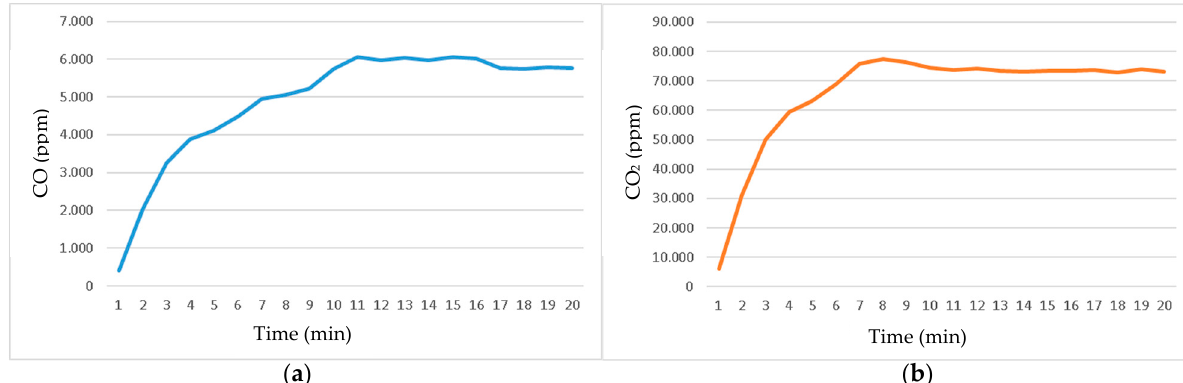
Figure 5. Fire pollutant emissions. ( a ) CO, ( b ) CO 2 .